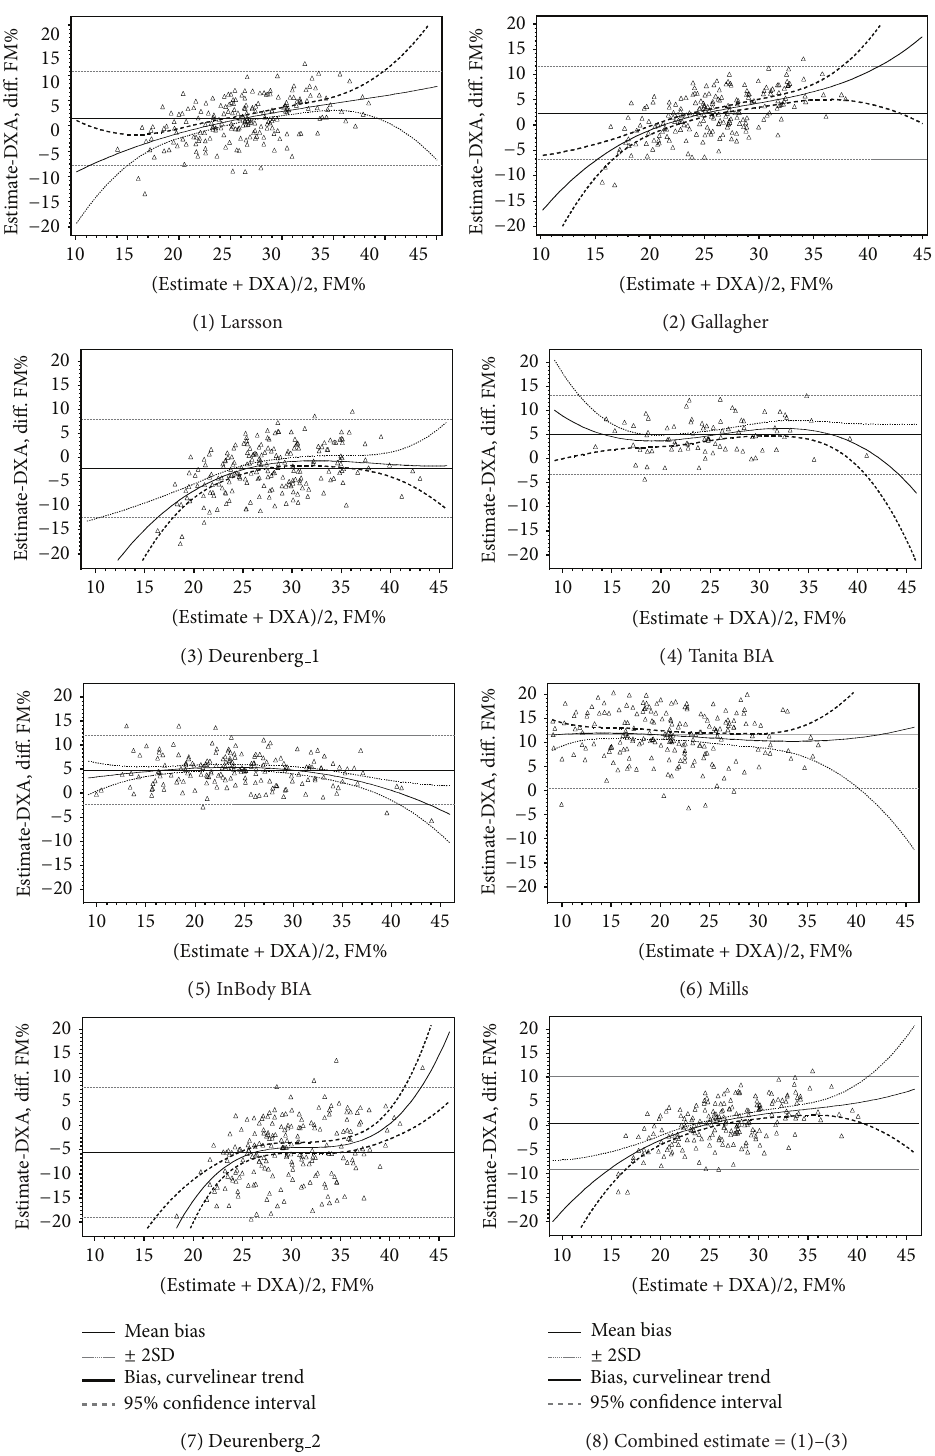
Figure 1: Bland-Altman plots for estimates of fat mass percent (FM%): DXA versus FM%-prediction equations and bioimpedance in men. Comparisons of predictive powers of the various obesity improved discrimination for grade 1 hypertension compared measures for hypertension grades 1 and 2 [19] and dyslip- to DXA by 1.5–1.9%. BMI and FM% equation-based cate- idaemia are given in Table 4. There were too few subjects gories of obesity had 1.2% lower discrimination for grade 2 with grade 3 hypertension to build stable mathematical mod- hypertension compared to DXA and 2.5–2.8% lower com- els. BMI, FM%-equation- and BIA-based categories of obesity pared to BIA. BMI categories provided 2.5–3.7%